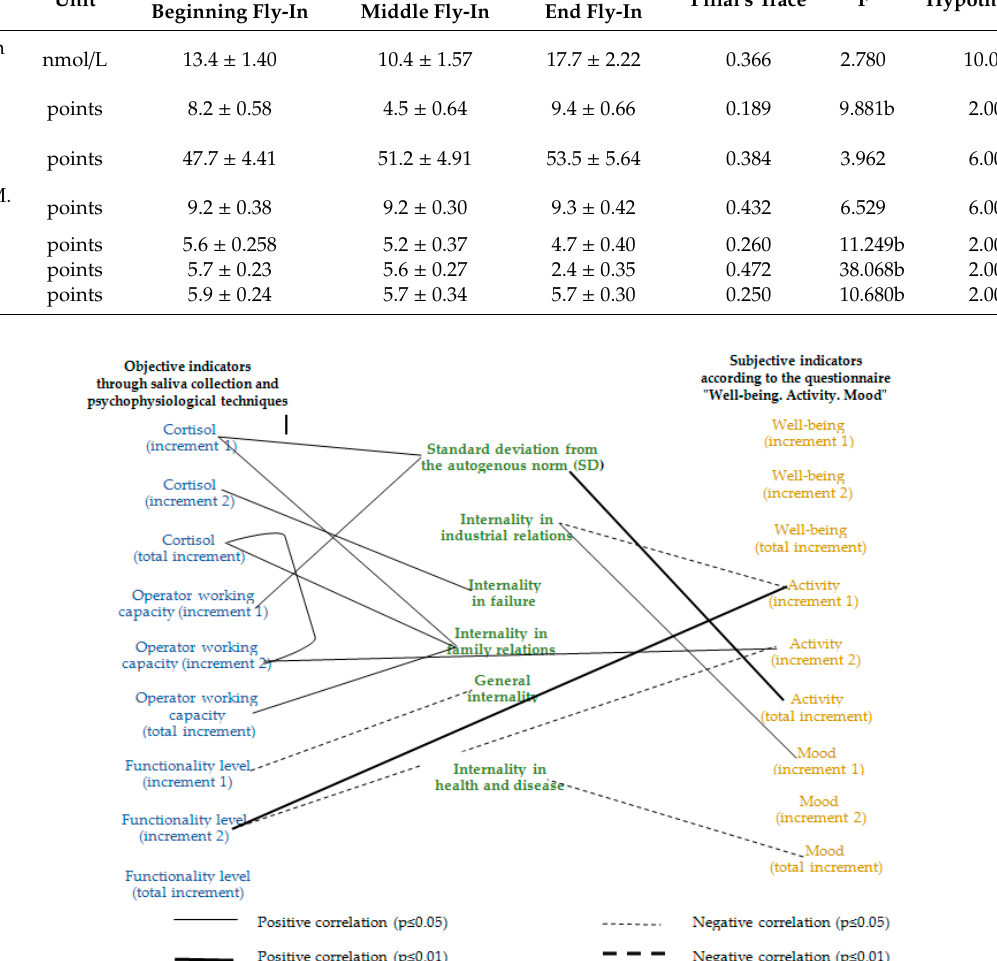
Figure4. Figure 4. Correlation relationship pleiad between the objective and subjective indicators of FIFO workers’ stress and working capacity in oil and gas production enterprise.